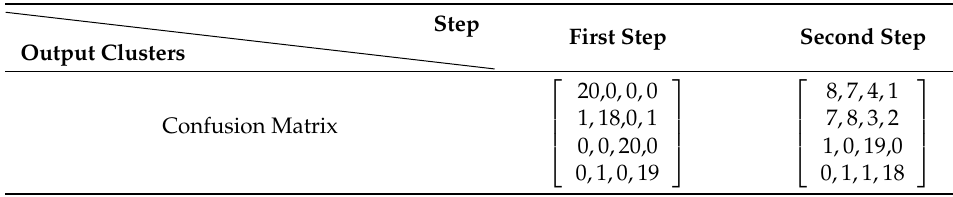
Table 10. CM of VFCSS applied over LR-type fuzzy numbers of Figures 4 and 5 (first and second steps of state 2).